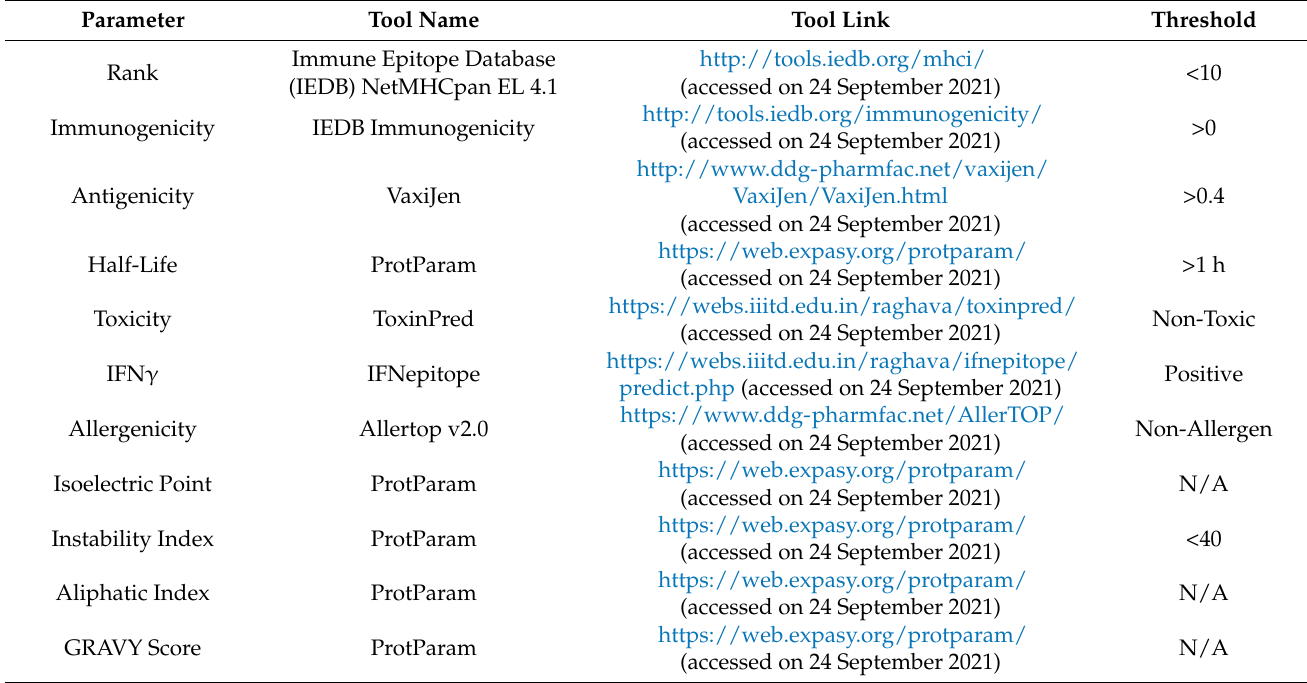
Table 1. Parameters collected for each predicted